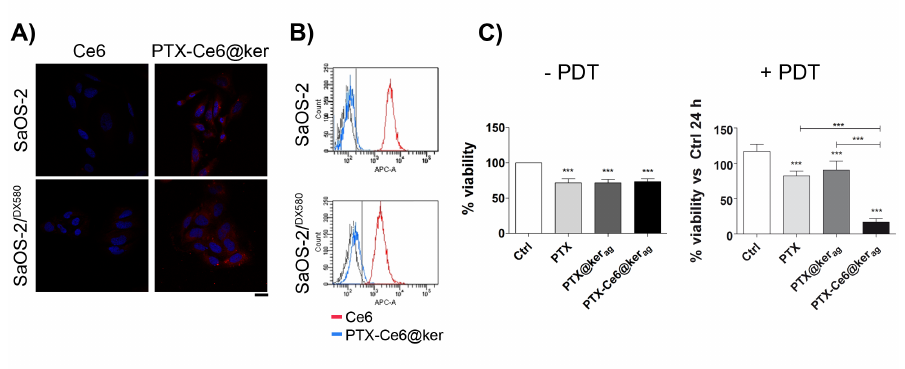
Figure 5. Impact of keratin nanoformulation on chemoresistant SaOS-2/ DX580 cells. ( A , B ) SaOS-2 and SaOS-2 /DX580 were treated for 24 h with Ce6 or PTX-Ce6@ker at a [Ce6] concentration of 3.35 µ M. ( A ) Representative confocal microscopy images of cells treated with Ce6 or PTX-Ce6@ker ag . Scale bar: 25 µ m. ( B ) the graphs show the Ce6 fluorescence after internalization of the photosensitizer by itself (blue line) or loaded into keratin nanoparticles (red line) quantified by flow cytometry analysis (Control, black line). ( C ) the graphs show the Alamar blue assay on SaoOS-2 /DX580 after 24 h treatment with PTX, PTX@ker ag , or PTX-Ce6@ker ag at an equivalent concentration of [PTX] of 13.4 µ M (High) and 24 h after irradiation (+PDT). All data are normalized to untreated cells (Ctrl) and expressed as